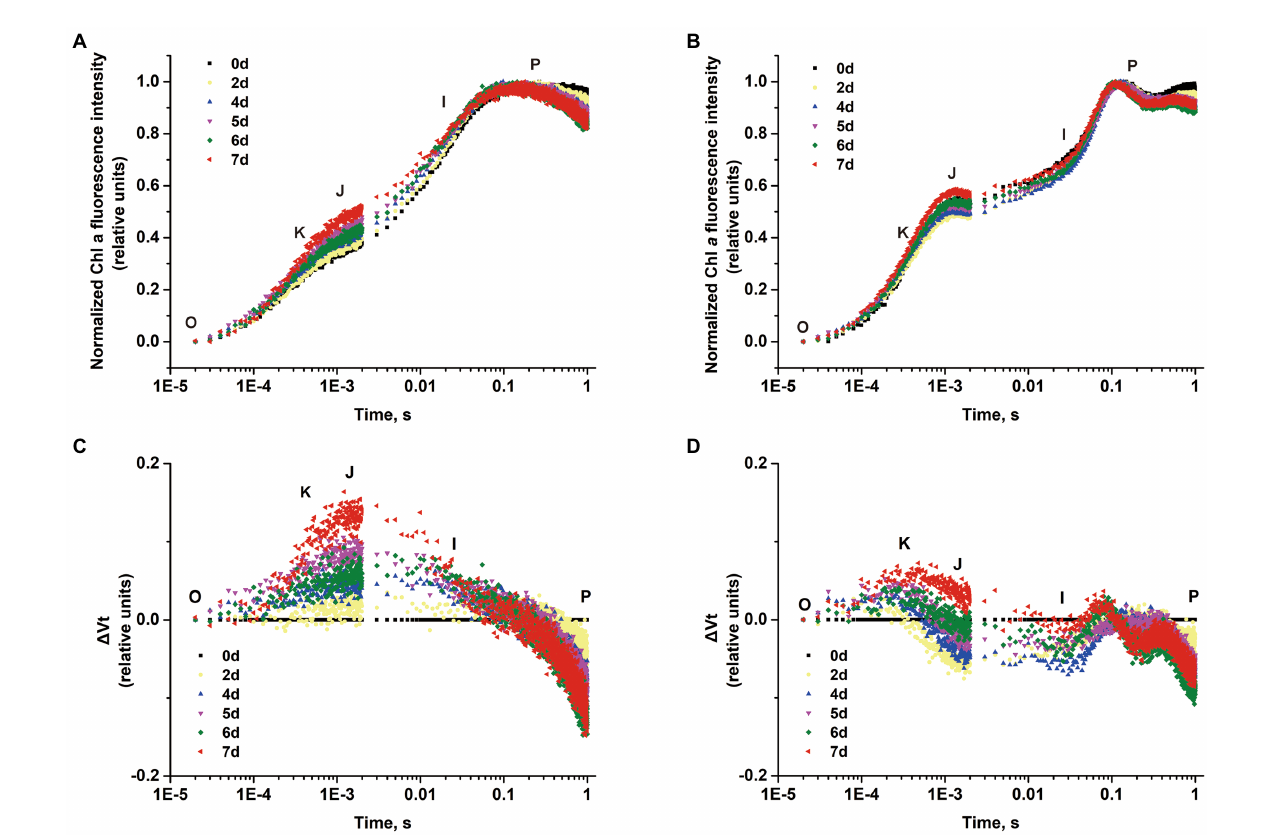
FIGURE 4 Normalized chlorophyll a fluorescence transient of S . costatum (A) and P . globosa (B) in − P group for various periods of time plotted by the mean of triplicate (Error bars omitted). Differential curves of Δ Vt (obtained by subtracting the curve on day 0 from the samples for various periods of time) in S . costatum (C) and P . globosa (D) under P-limited condition.